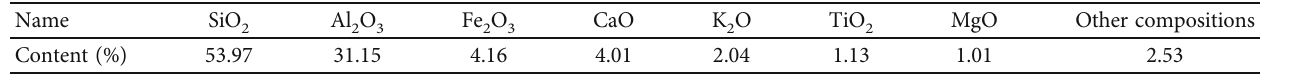
Table 2: Chemical composition of the fl y ash.